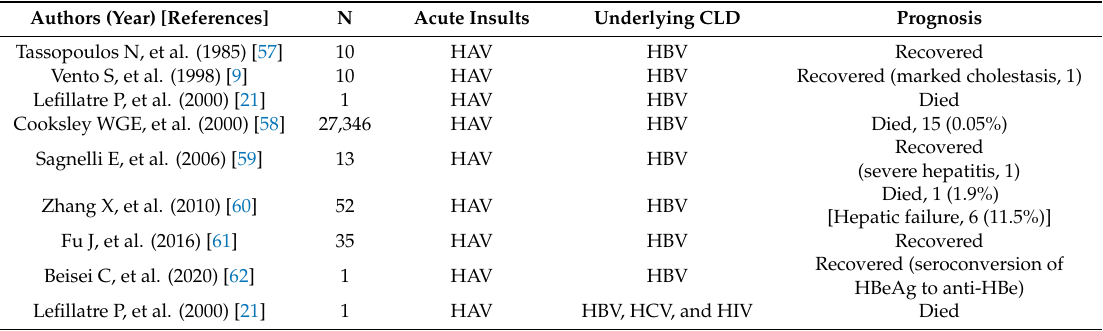
Table 3. Acute-on-chronic liver failure and / or superinfection of hepatitis virus (HAV) in patients with hepatitis B virus